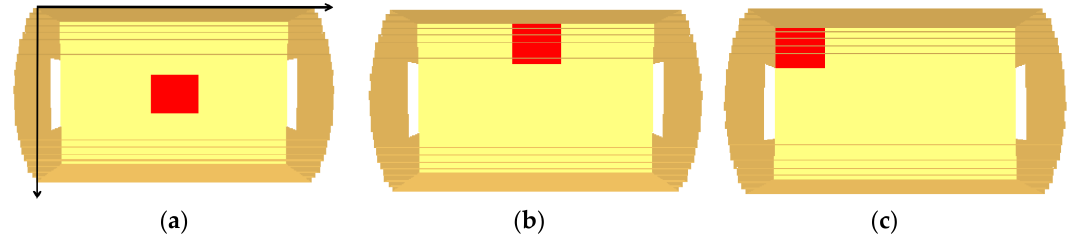
Figure 2. Fire source locations. ( a ) Location I-fire in the center; ( b ) location II-fire in the middle of the longitudinal side; ( c ) location III-fire at the corner.